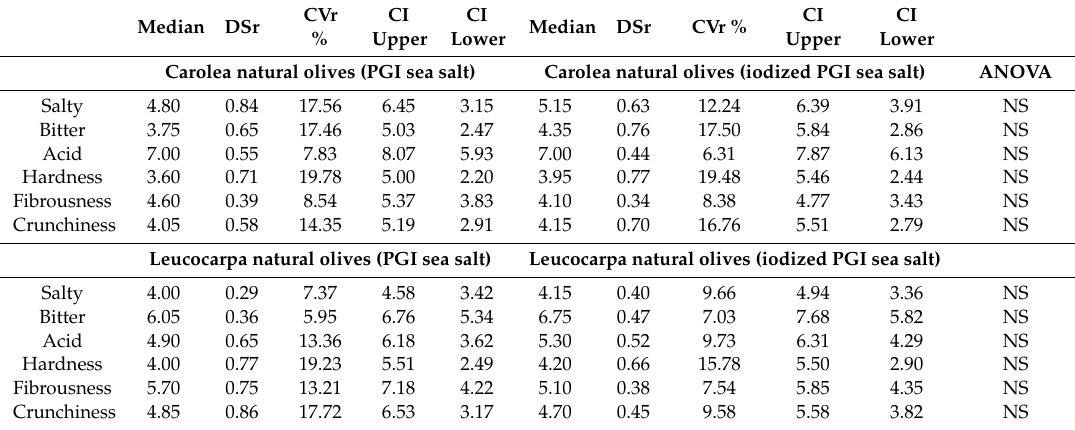
Figure 6. Sensory profiles of processed table olives. Table 5. Evaluation of sensory attributes. NS = not